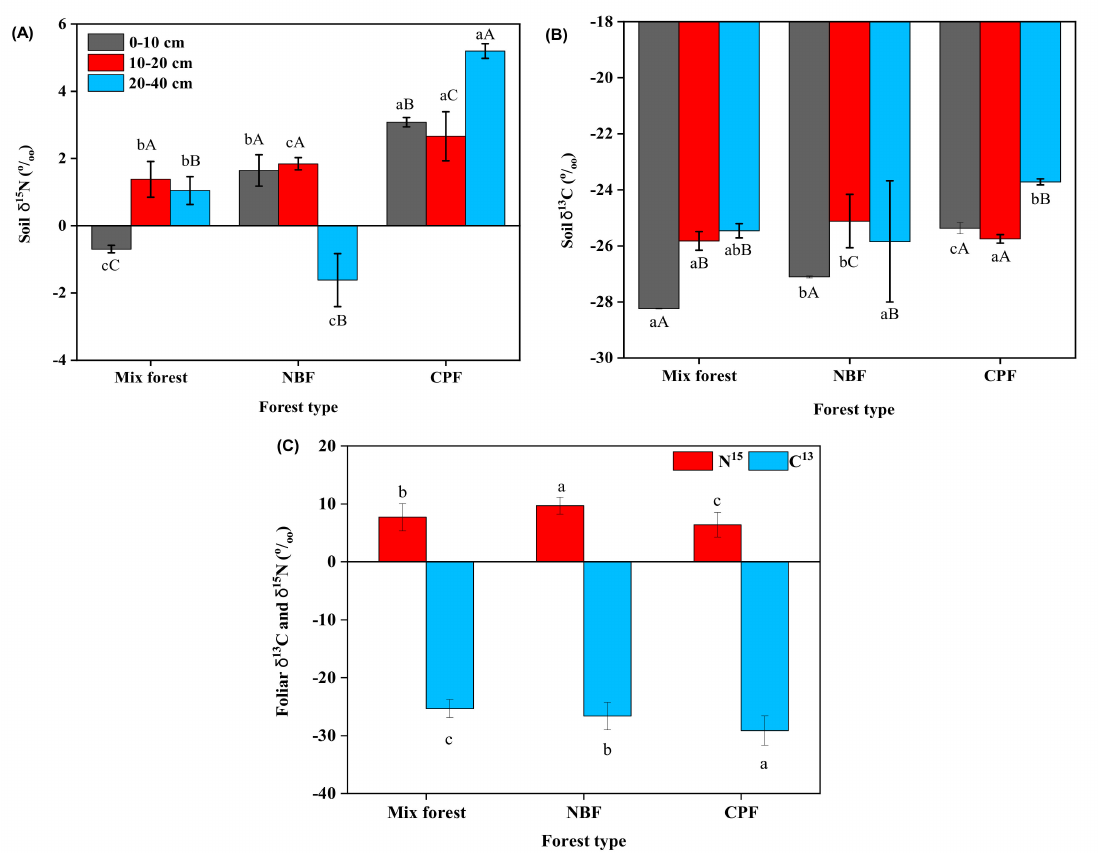
Figure 2. The natural abundance of ( A ) soil 15 N (‰) and ( B ) soil 13 C (‰) at different soil depths and ( C ) foliar 15 N (‰) and 13 C (‰) in different forest types. Values are means ± SE. The different small letters represent the significant differences between forest types, and different capital letters represent the significant difference between different soil depths p ≤ 0.05.